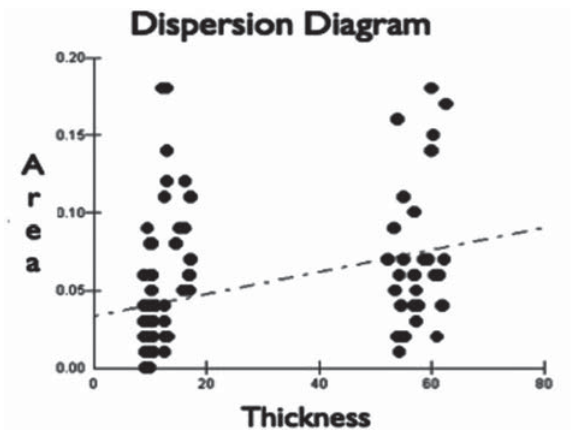
Figure 4- Pearson’s correlation test dispersion diagram - thickness x marking area